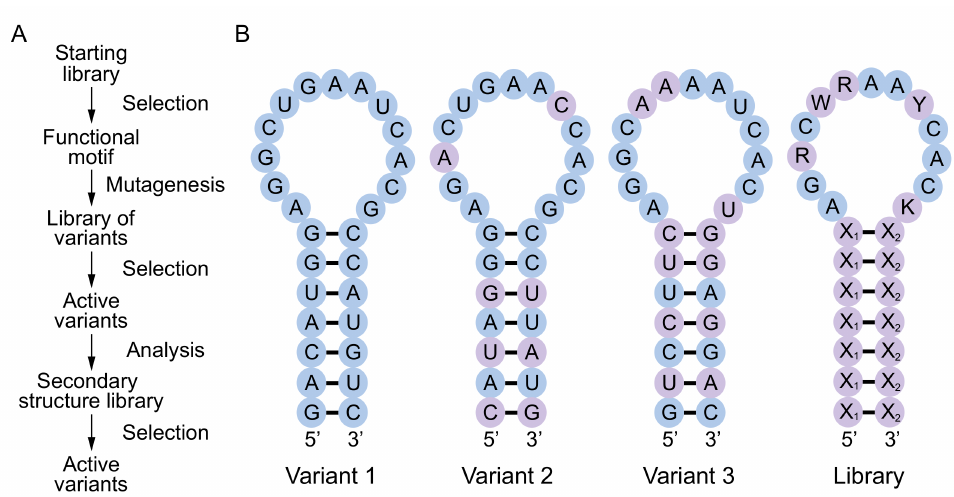
Figure 1. Concept and design of a secondary structure library. ( A ) Typical workflow to identify and optimize a functional nucleic acid motif. The starting library usually contains ~10 15 random sequences flanked by primer binding sites. After identifying functional motifs by selection, a second library is prepared by randomly mutagenizing a single sequence corresponding to one of the most active variants at a rate of 15% to 25% per position. Additional rounds of selection are performed to identify active variants of this sequence, most of which will adopt the same fold. Information from these variants can be used to design a secondary structure library, which is the topic of this paper. ( B ) Design of a secondary structure library. In this hypothetical example, variants 1–3 are three variants of a functional RNA motif from the “active variants” step of the workflow in panel a. A secondary structure library combining information from these three variants is shown on the right. Nucleotides that differ from variant 1 are shown in purple. X 1 -X 2 = A-U, U-A, C-G, G-C, G.U, or U.G; R = A or G; W = A or U; Y = C or U; K = G or